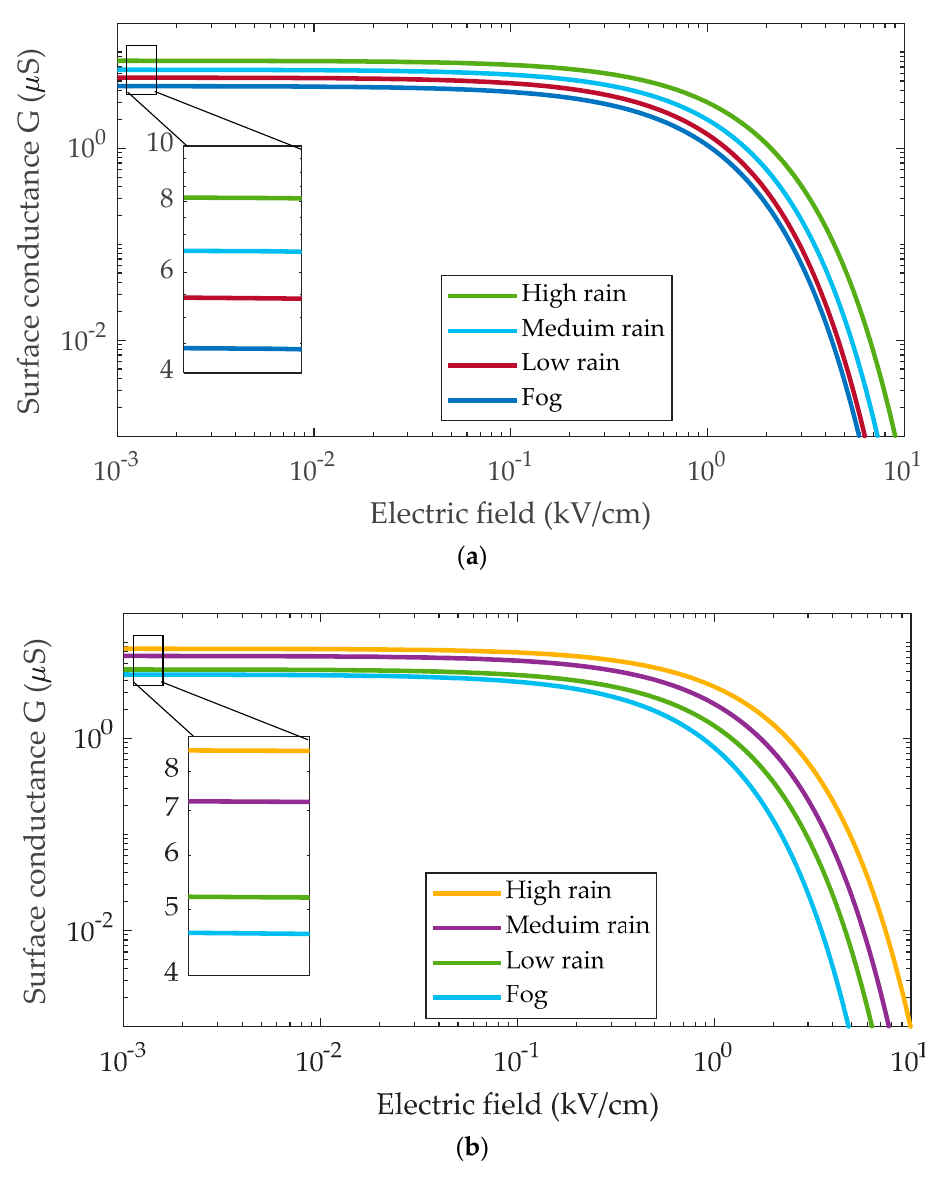
Figure 10. Relationship between the surface conductance and electric field under different wetting levels during a period of testing for ( a ) insulator type I; ( b ) insulator type II.